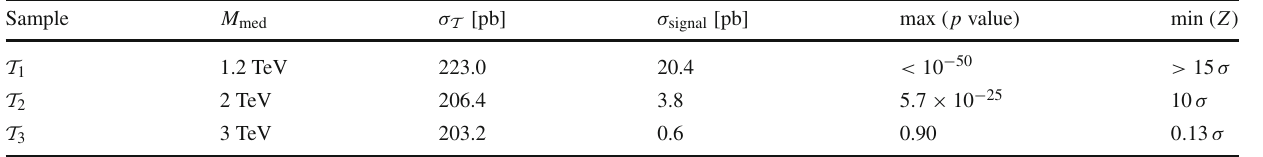
indicates that T is not consistent with the background-only hypothesis. Note that these results will be weakened by application of uncertainties (see text for details) < 10 − 50 > 15 σ . 13